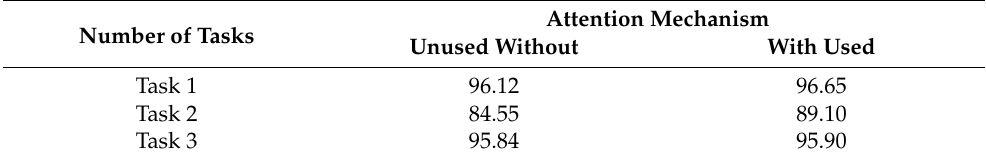
Table 3. Accuracy about the usage of attention mechanism for each task.